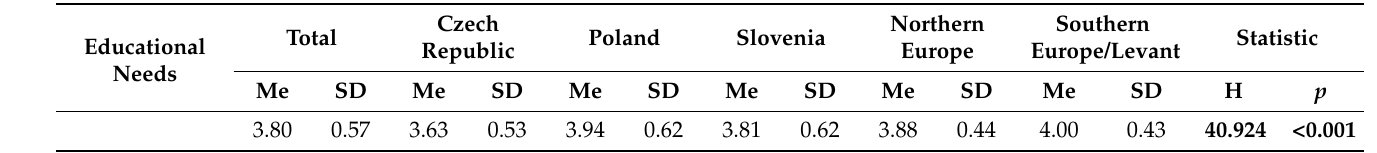
Table 2. Self-assessment of knowledge/skills of ICU nurses regarding multicultural care and their educational needs in this scope.